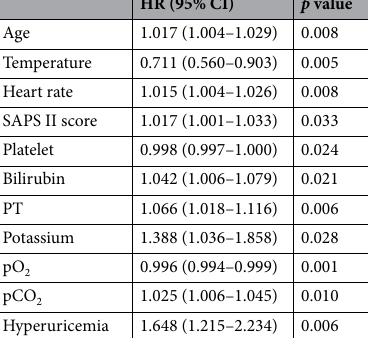
HR (95% CI) p value